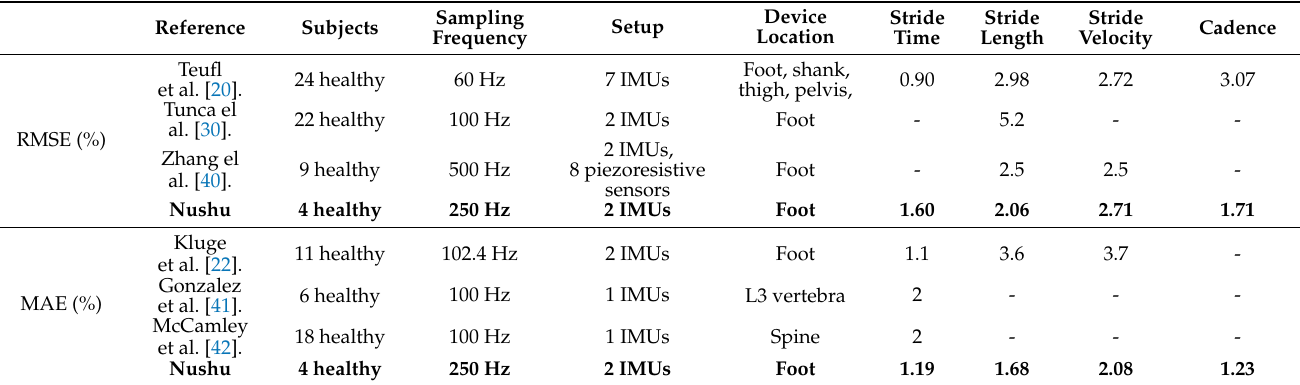
Table 4. Accuracy comparison of RMSE (%) and MAE (%) between recent wearable devices and proposed Nushu